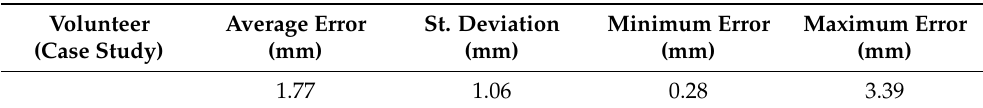
Table 1. Displacement error for the positioning markers between the 3D geometry and the 3D thermal